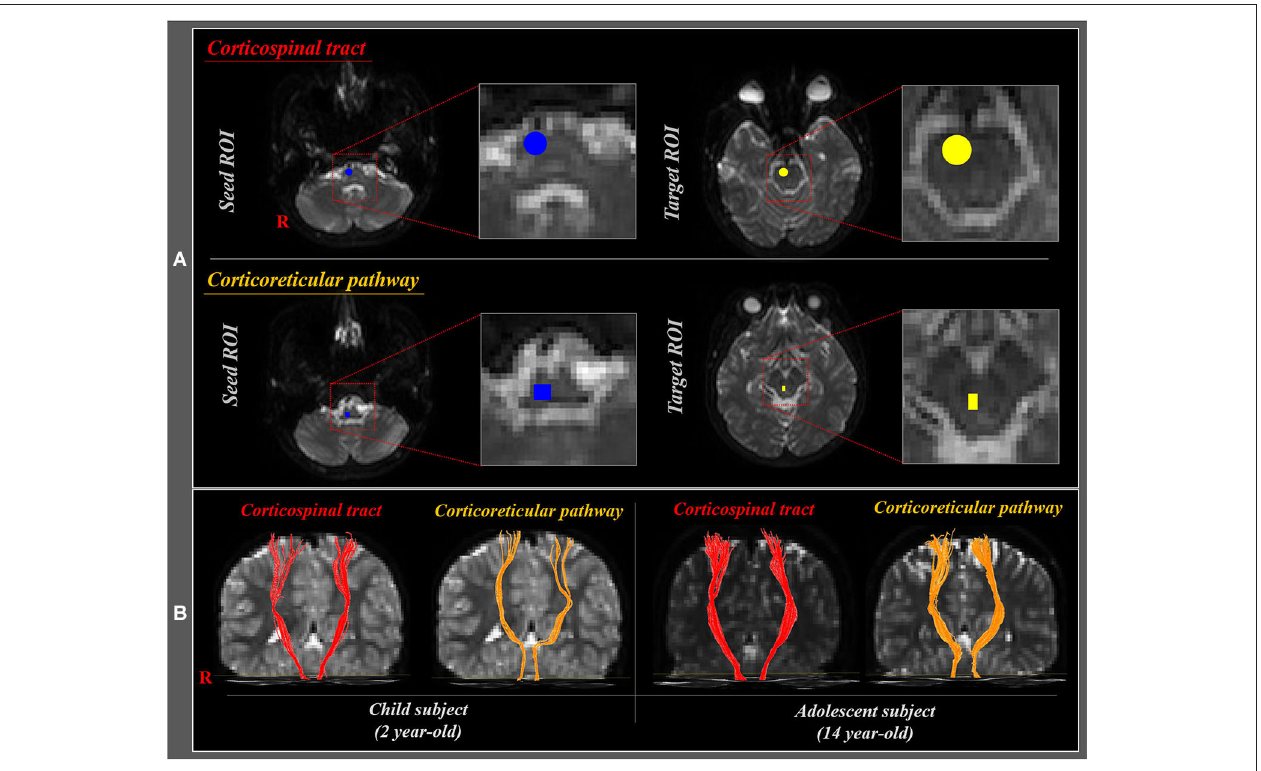
the CRP, seed ROI was given on the medullary reticular formation (blue rectangle), and the target ROI was placed on the midbrain tegmentum (yellow rectangle). (B) Diffusion tensor tractography (DTT) of the CST and CRP in child (2 year-old) and adolescent (14 year-old)